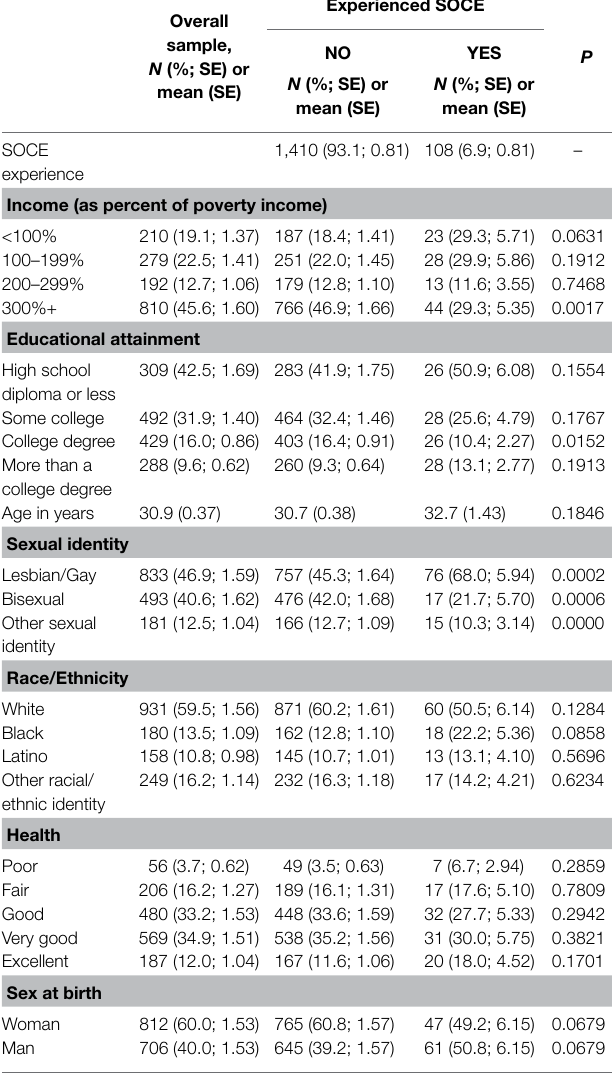
TABLE 1 | Demographic characteristics of lesbian/gay individuals, by experiencing sexual orientation change efforts (SOCE), counts, and weighted proportions: probability sample of sexual minorities, United States, 2016–2018 ( N =